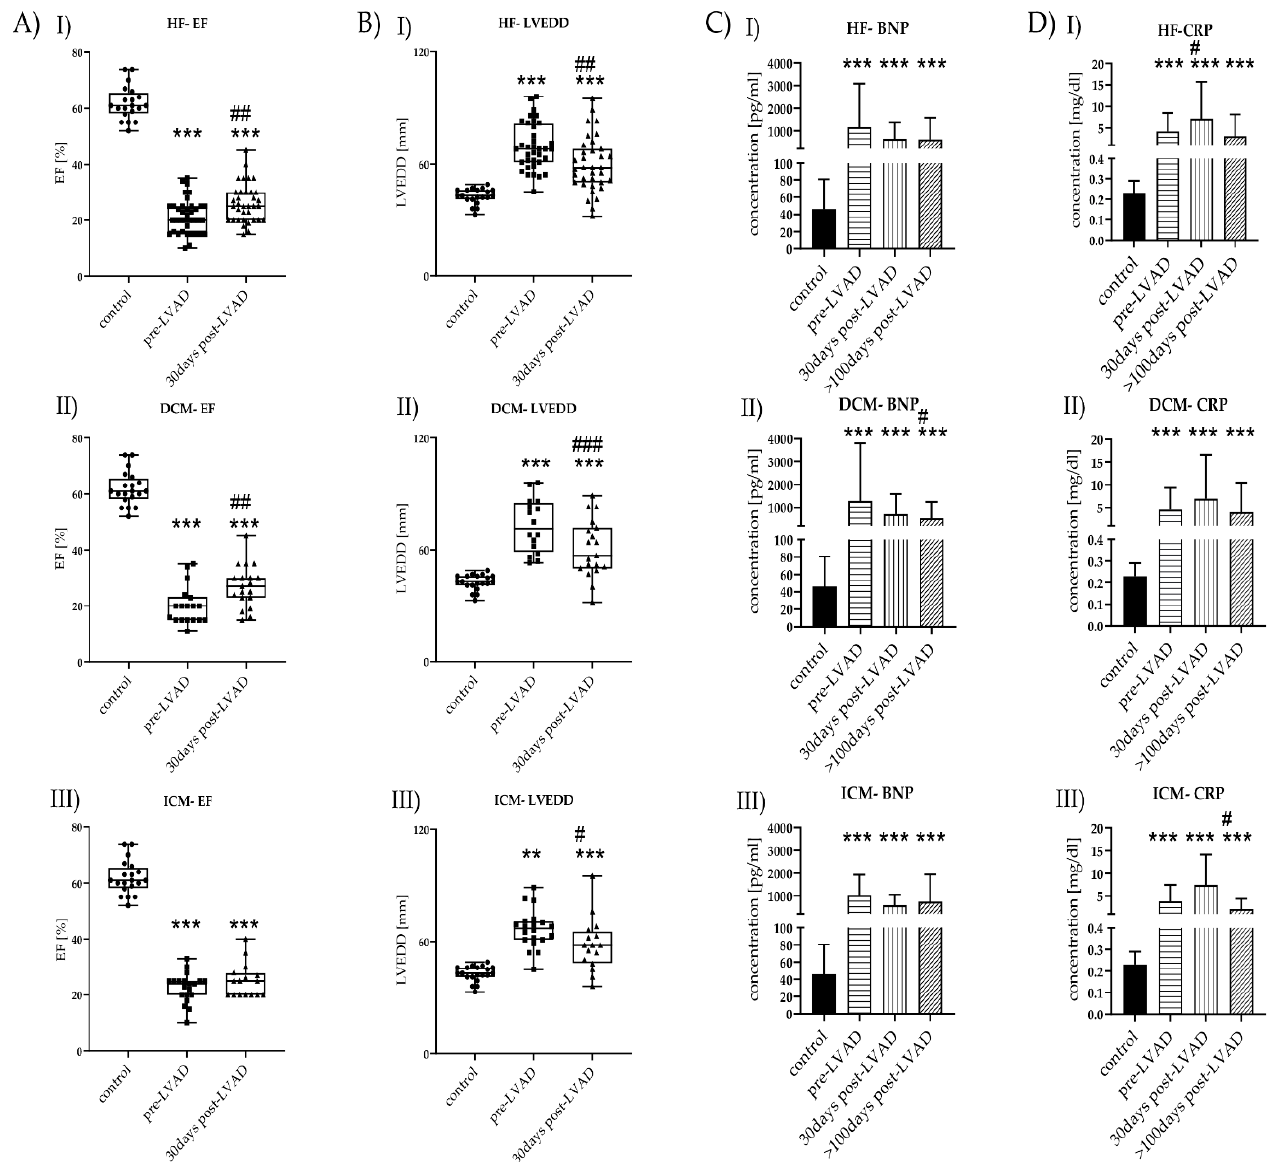
Figure 1. Time course of laboratory and clinical markers before and after LVAD implantation of HF (I), DCM (II), and ICM (III) . ( A ) LV-EF levels of control ( n = 20) vs. HF ( n = 40), control vs. DCM ( n = 20), and control vs. ICM ( n = 20), all with pre-LVAD and 30 days post-LVAD. Depicted are min, max, median, and single values. Significance was calculated with a t -test or the Mann–Whitney U test. * indicates significant to control (*** = p < 0.001). # indicates significant to pre-LVAD (## = p < 0.01). ( B ) LVEDD levels of control vs. HF, control vs. DCM, and control vs. ICM, all with pre-LVAD and 30 days post-